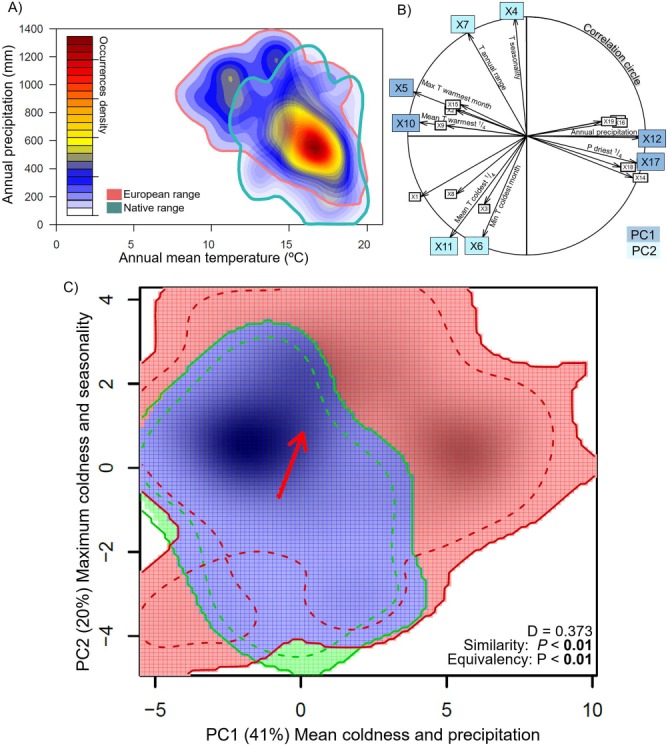
(A) Kernel density estimation for C. edulis occurrences in response to annual mean temperature and precipitation. (B) Correlation circle for the PCA-env analysis, with the 19 bioclimatic WorldClim variables (X1-19). Bioclimatic variables full names can be found at: http://worldclim.org/bioclim. (C) Niche dynamics: stability, expansion and unfilling (in blue, red and green respectively) in the multivariate climatic space for native compared to the European niche of C. edulis considering the two first components from the PCA-env. D Stands for Schoener’s D overlap value. Solid and dashed lines delineate 100 and 75% of the available background environment, respectively.